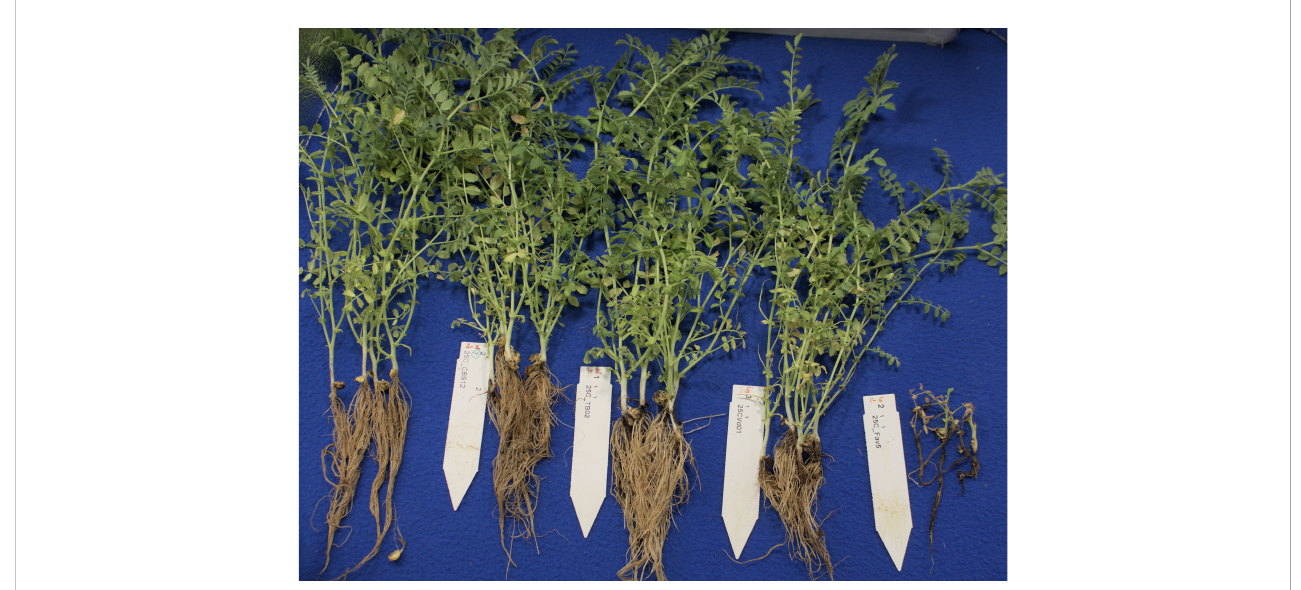
FIGURE 6 Root rot symptoms caused by four pathogens on 3-week-old plants CDC Leader kabuli chickpea under controlled conditions. Inoculum was incorporated into soil at planting or applied as a seedling dip, and applied by soil drenching 10 days after seeding or transplanting. From left to right: non-inoculated control, Macrophomina phaseolina , Berkeleyomyces basicola , Verticillium dahliae , Fusarium avenaceum .